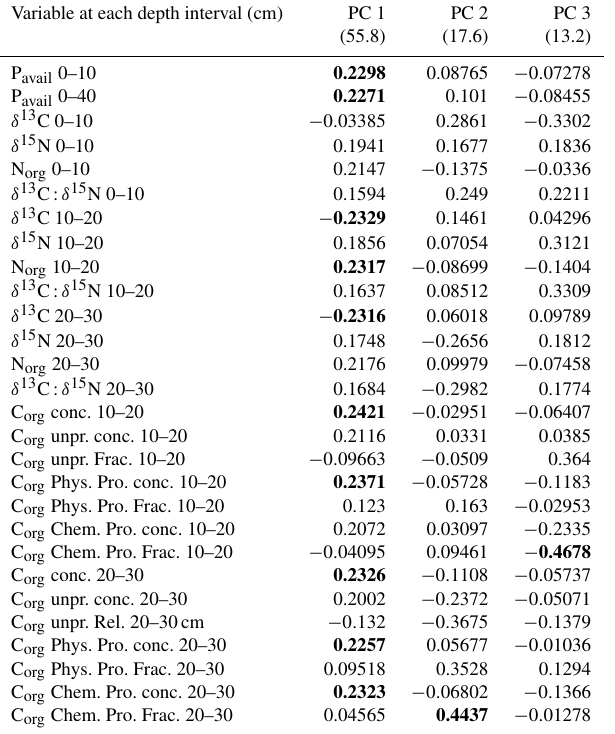
Table 6. Loads of selected variables in the PCA for the first three principal components (PCs). The values in brackets below PC 1, 2, and 3 indicate the percentage of variance explained by this PC. Vari- ables in bold are those with a load higher than 90% of the variable with the maximum load for this PC. Conc. refers to C org concen- tration for this fraction, and Frac. means the relative contribution of this fraction to the total C org for this soil depth. Variable at each depth interval